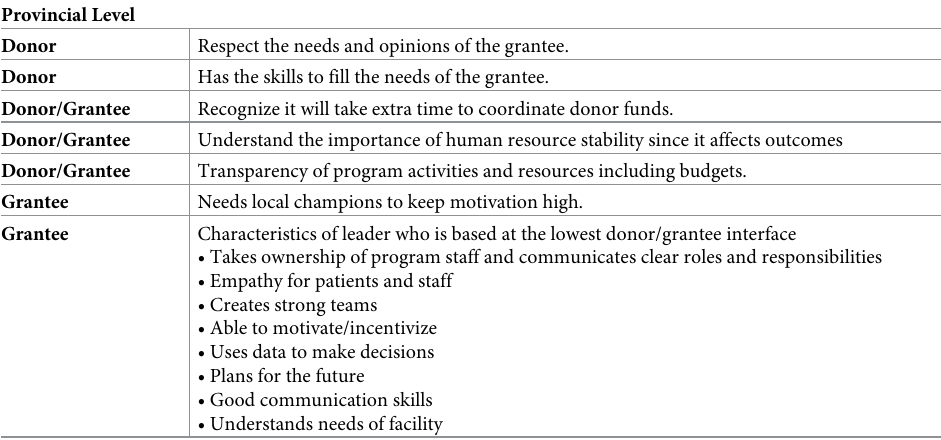
Table 4. Beginning of the